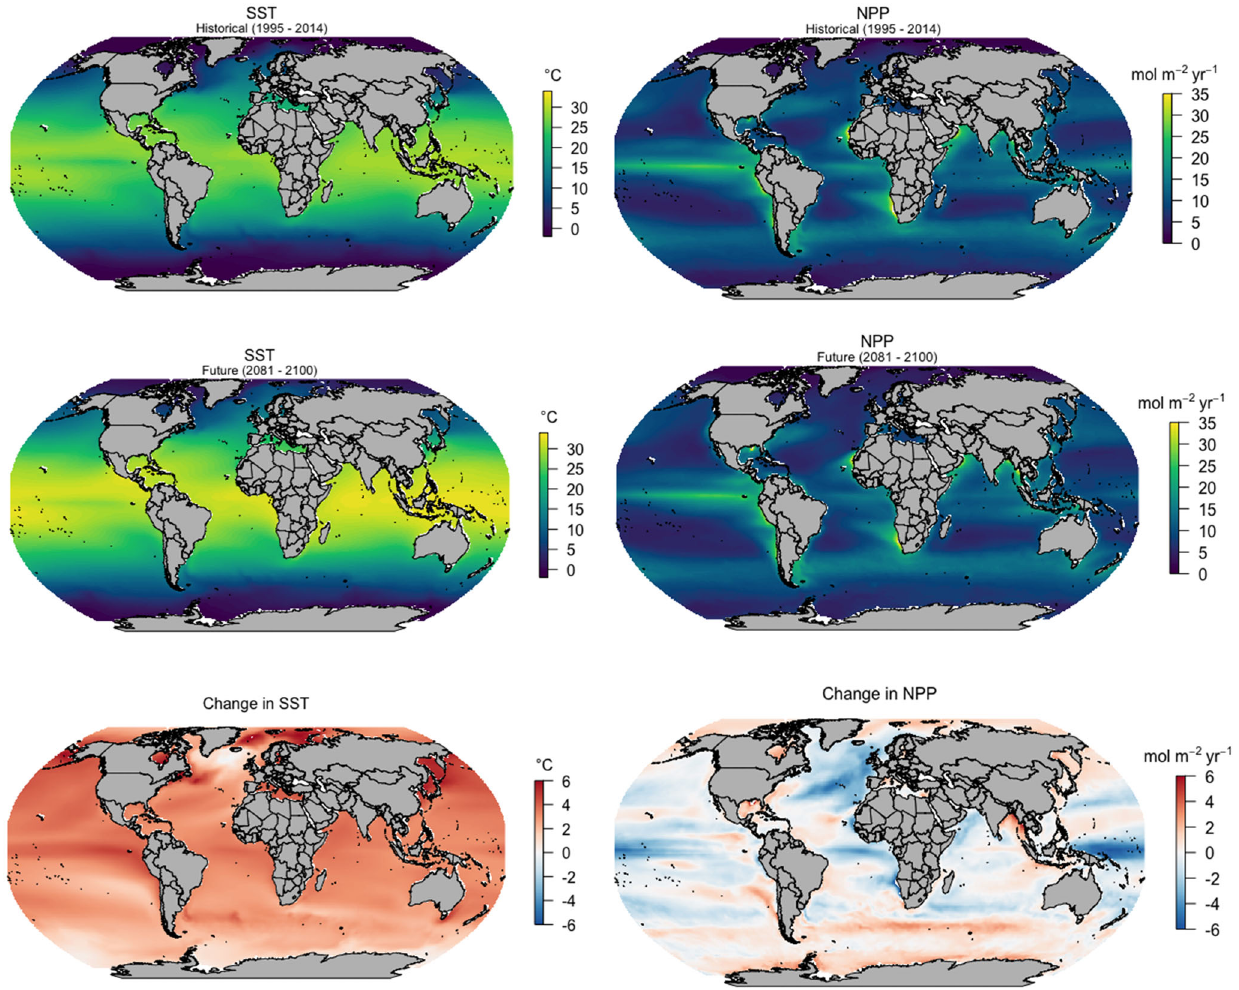
Fig. 1 | Predicted changes in sea surface temperature (SST) and net primary productivity (NPP) for the global ocean. Multi-model mean projections for SST andNPPfrom10CMIP6Earthsystemmodelsforthehistoricalperiod(1995 – 2014), future (2081 – 2100) and the change in SST and NPP by 2081 – 2100 relative to 1995 – 2014 based on SSP5 – 8.5. Publicly available datasets were analysed in this